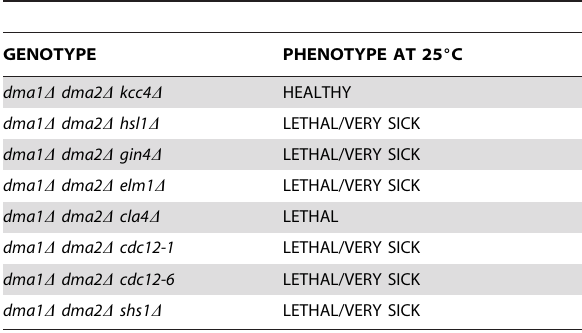
Table 1. Synthetic effects between the lack of Dma proteins and mutations affecting septin